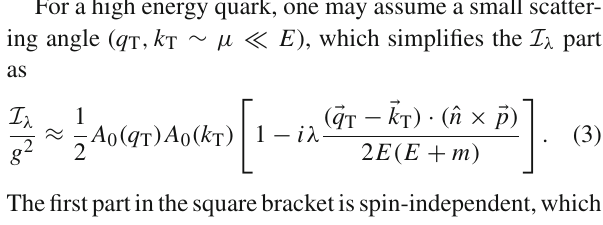
In the above equations, C T = 2 / 9 is the color factor associ- (cid:2) 0 ) is the scattering potential, ated with the target, A μ = ( A 0 , (cid:2) (cid:2) q k T ) is the momentum transfer between the quark and T ( the potential in the real (complex conjugate) space, (cid:2) x T is the relative transverse distance pointing from the scattering cen- ter to the quark (as illustrated in Fig. 2), and m is the quark mass. After being scattered, the outgoing quark momentum (cid:2) k T ) . Here, we have averaged over the is (cid:2) p q ( k ) = (cid:2) p + (cid:2) q T ( initial spin states ( λ i ) for the unpolarized projectile